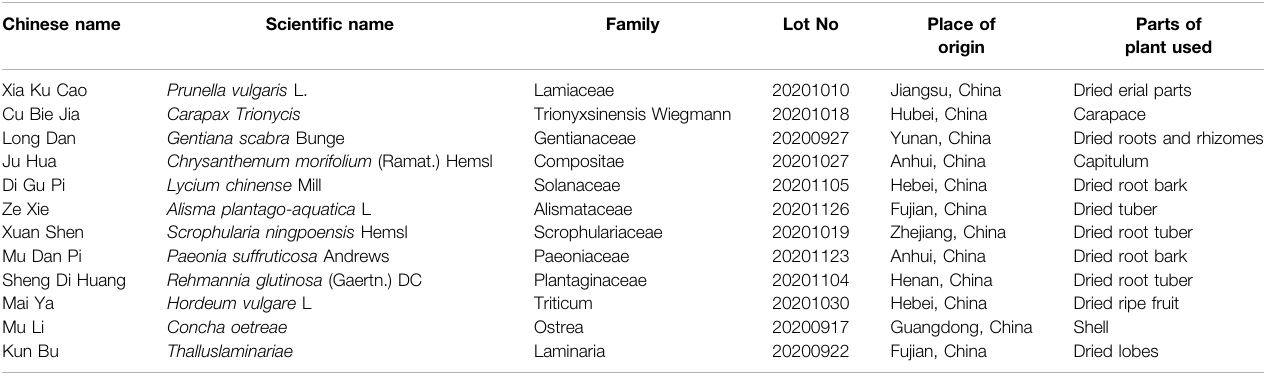
TABLE 1 | Composition of the FY.